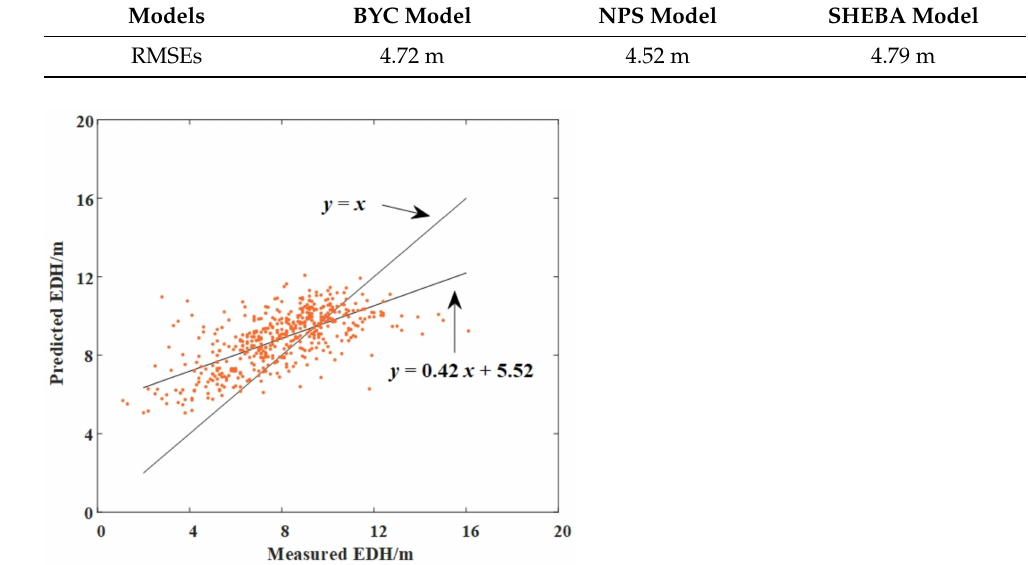
Figure 4. The EDH fitting line by the MAGIC datasets and inverted by the NPS